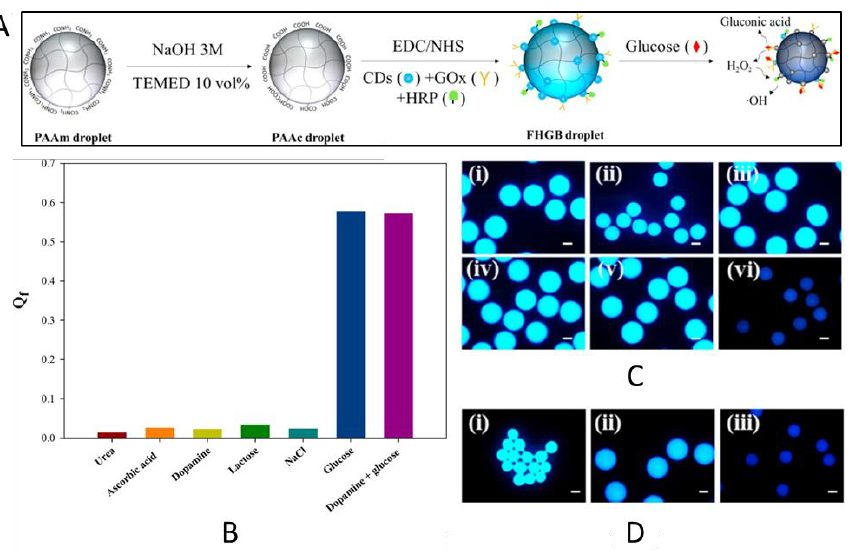
Figure 6. ( A ) Schematic of the preparation of the FHGB droplets. ( B ) Q f of the hydrogel biosensor droplets (0.05 g) after ( i ) urea, ( ii ) ascorbic acid, ( iii ) dopamine, ( iv ) lactose, ( v ) NaCl, and ( vi ) glucose aqueous solutions (30 mM, 2 mL) are added to the cell, ( C ) fluorescence images of panel a, and ( D ) fluorescence images of the FHGB droplets in ( i ) the dried state, and ( ii , iii ) the swollen state in water, ( ii ) without, and ( iii ) with 30 mM glucose 4 weeks after drying; all scale bars in b and c are 200 μm; the PL spectra in panel a were obtained following 5 h of incubation. (Reprinted and adapted with permission from [69]. Copyright 2018 American Chemical Society).